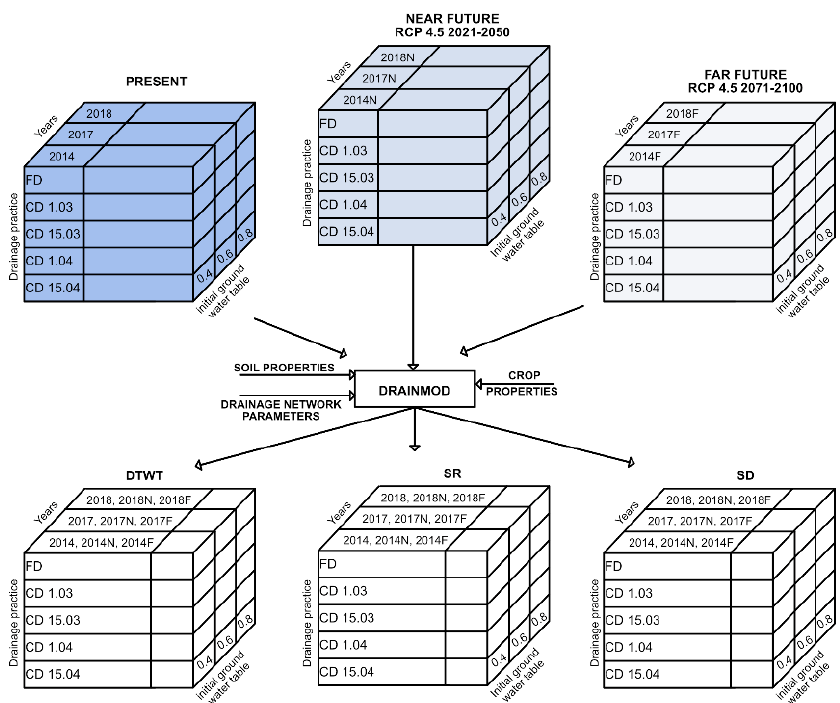
Figure 3. Simulation procedure (FD-free drainage, CD-Control drainage, SR-surface runoff, SD-subsurface drainage, RCP-Representative Concentration Pathway, DTWT-depth to groundwater table, N-near future, F-far future).